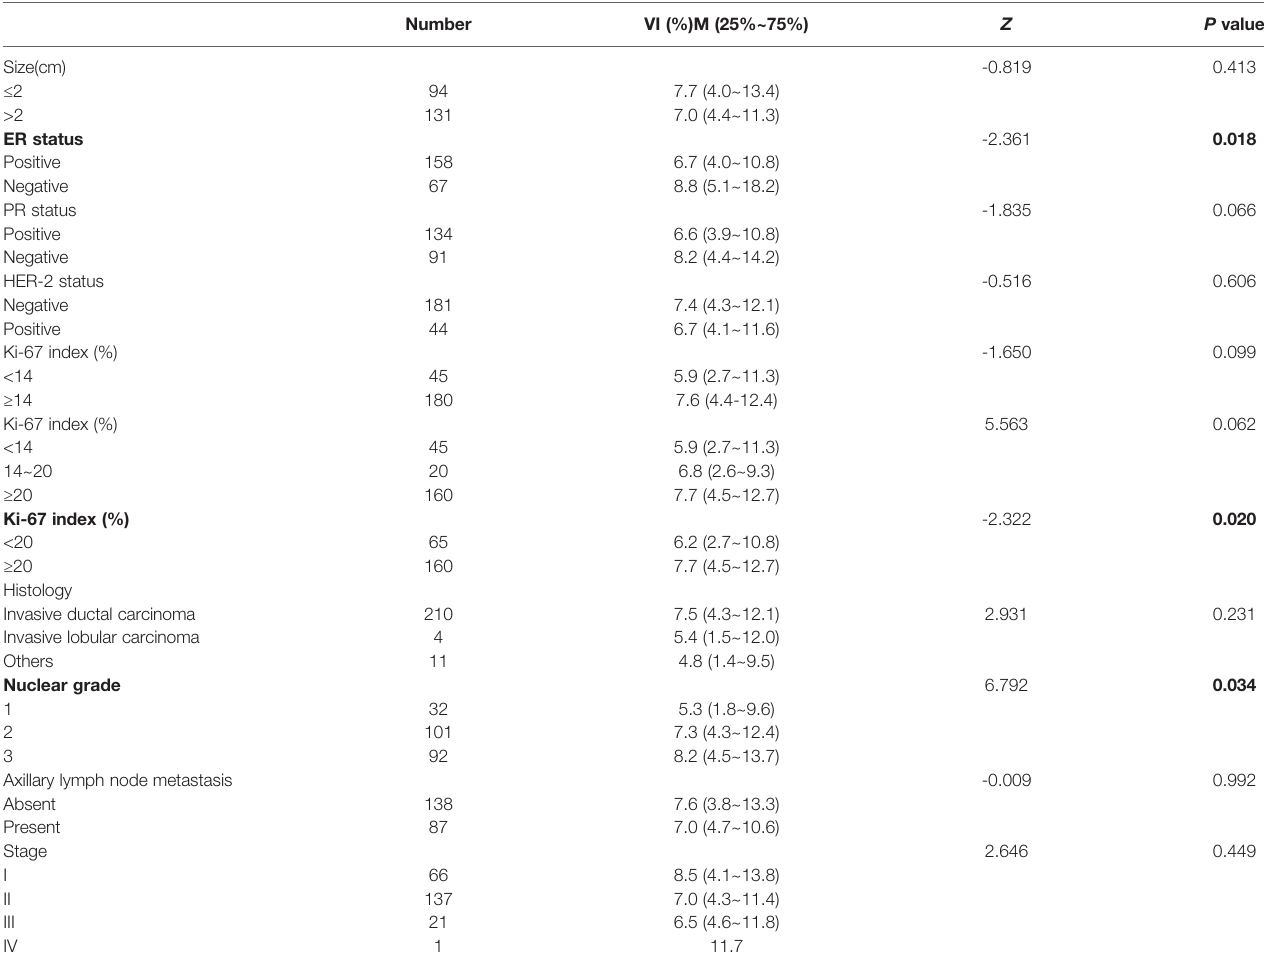
TABLE 1 | Correlations between clinicopathological and vascular index (VI) values of breast